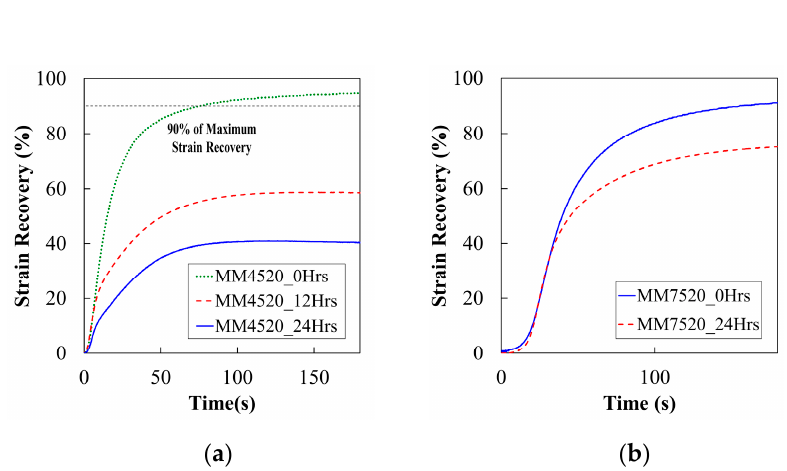
Figure 11. Representation curves for strain recovery of ( a ) MM4520 at activation temperature T = 50 °C and ( b ) MM7520 after different immersion times in water at activation temperature T = 80 °C.